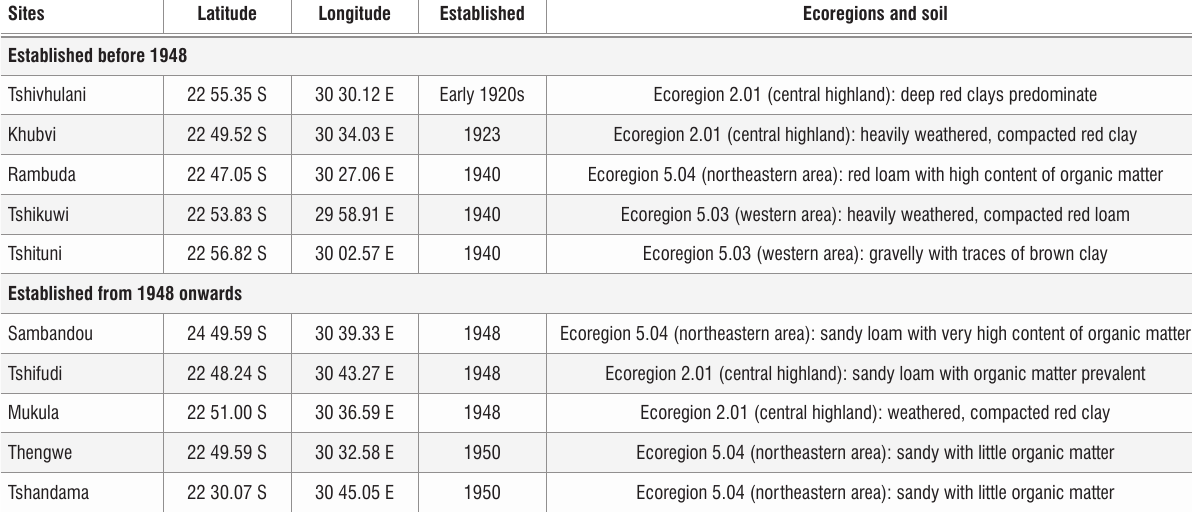
Locations and features of 10 dip tank sites in the Vhembe district, Limpopo Province of South Africa Sites Latitude Longitude